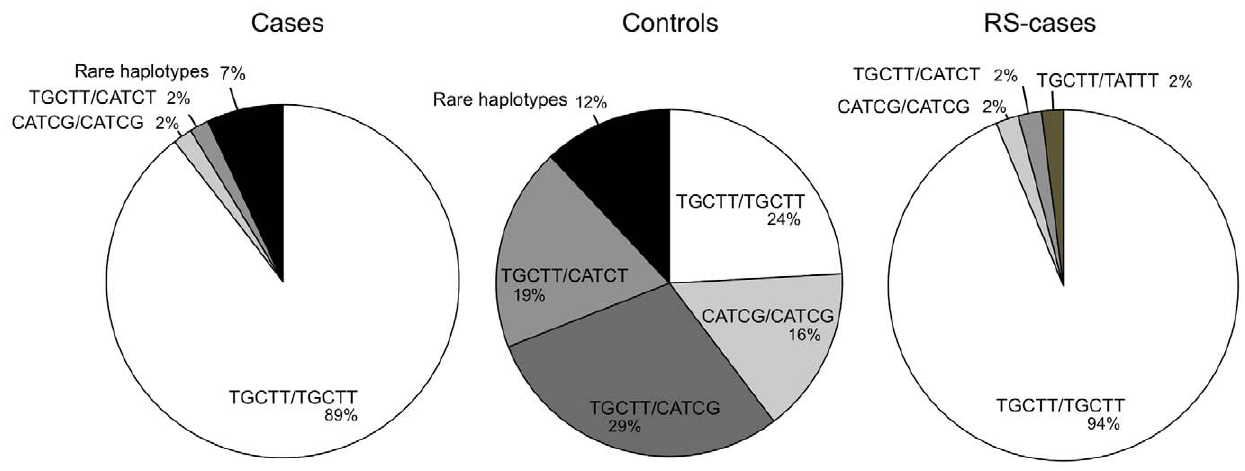
Figure 2. Distribution of the most common haplotypes. Genotype frequencies of haplotypes in cases, controls and the replication study cases (RS-cases) are plotted as pie charts for the most common haplotypes of the FXN 3 9 -UTR (TGCTT, CATCG, CATCT). Haplotype TATTT was uniquely found among RS-cases.